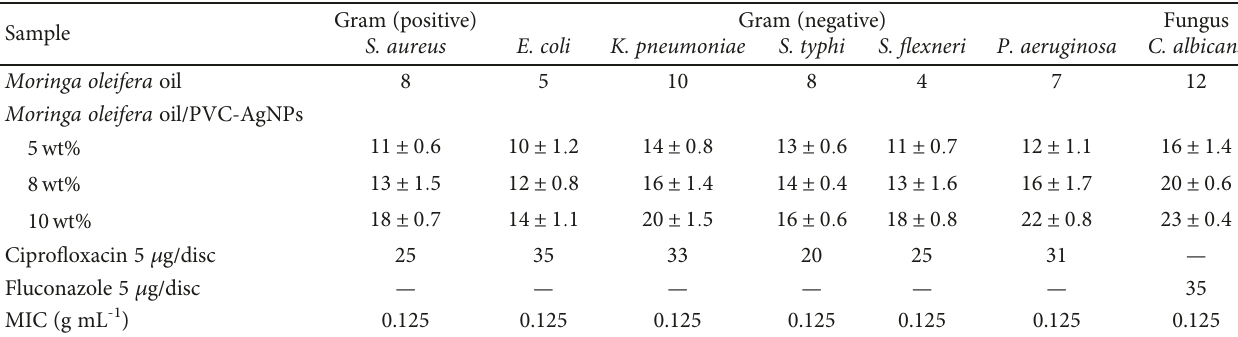
Table 2: Antimicrobial activity of M. oleifera seed oil and M. oleifera oil/PVC-AgNPs. Gram (positive) Gram (negative) Sample